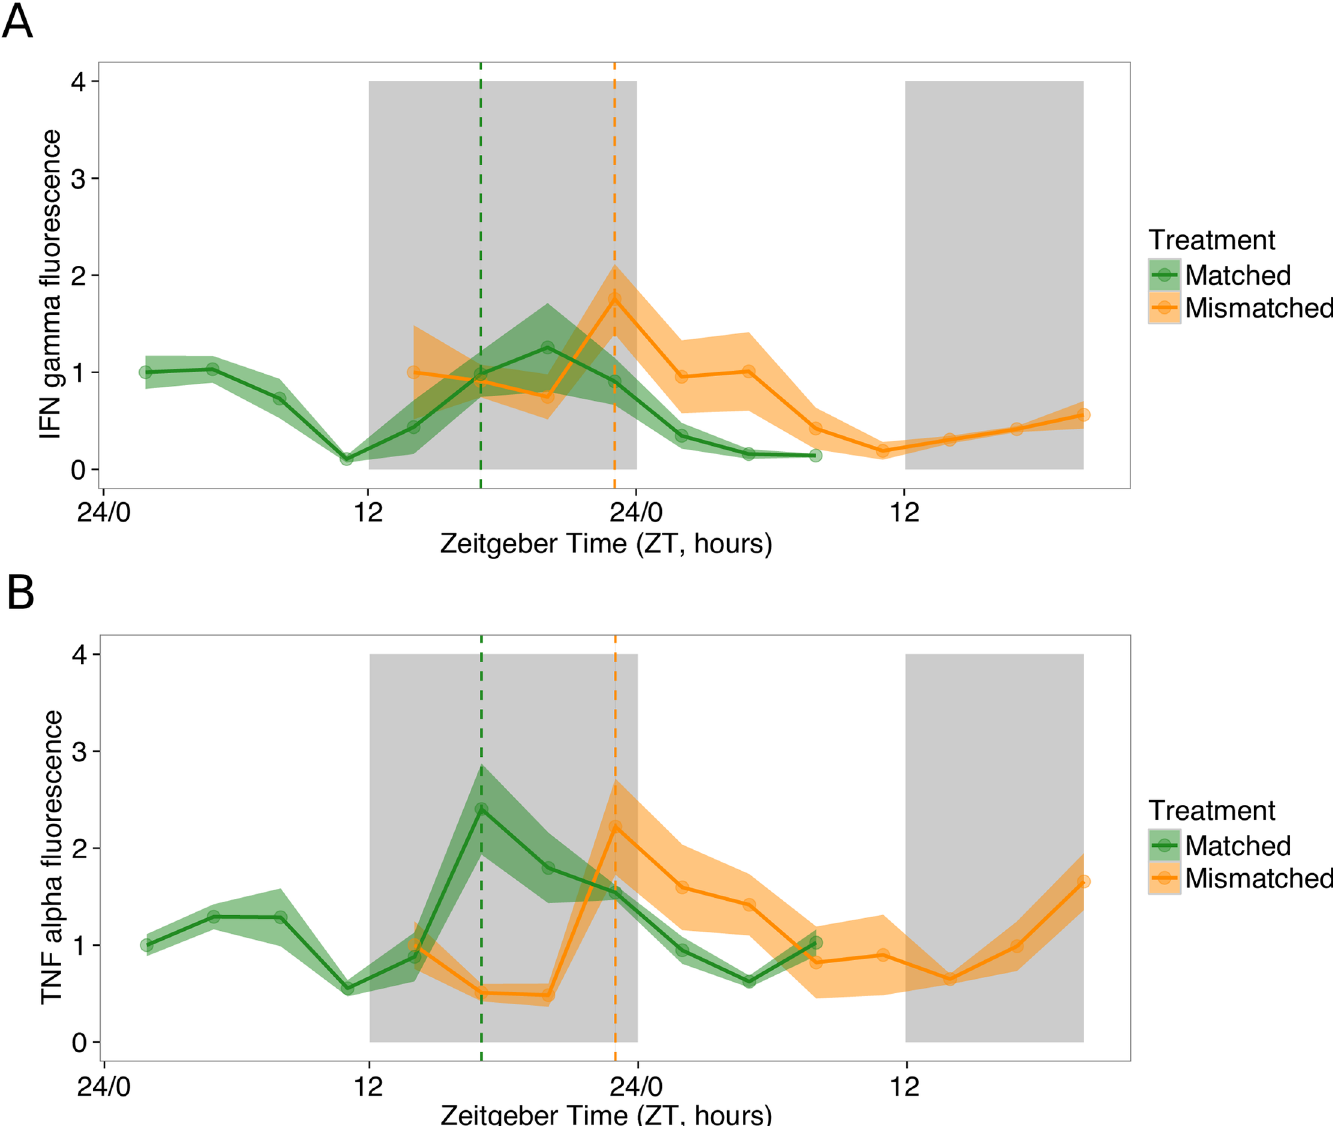
Fig 5. Rhythms in inflammatory cytokines follow rhythms in parasite development. Mean ± SEM (N = 4 per time point) for cytokines (A) IFN-gamma and (B) TNF- alpha for parasites matched and mismatched to the SCN rhythms of the host (matched: green, mismatched: orange). Sampling occurred every 3 hours on days 4–5 post infection. Matched parasites undergo schizogony around ZT 17, (indicated by green dashed line) and mismatched parasites undergo schizogony 6 hours later, around ZT 23 (indicated by orange dashed line). IFN-gamma peaks at ZT 21.29 in matched infections (green) and at ZT 0 in mismatched infections (orange). TNF-alpha peaks at ZT 19.26 in matched infections (green) and at ZT 1.29 in mismatched infections (orange). Light and dark bars indicate lights on and lights off (lights on: ZT 0, lights off: ZT 12).